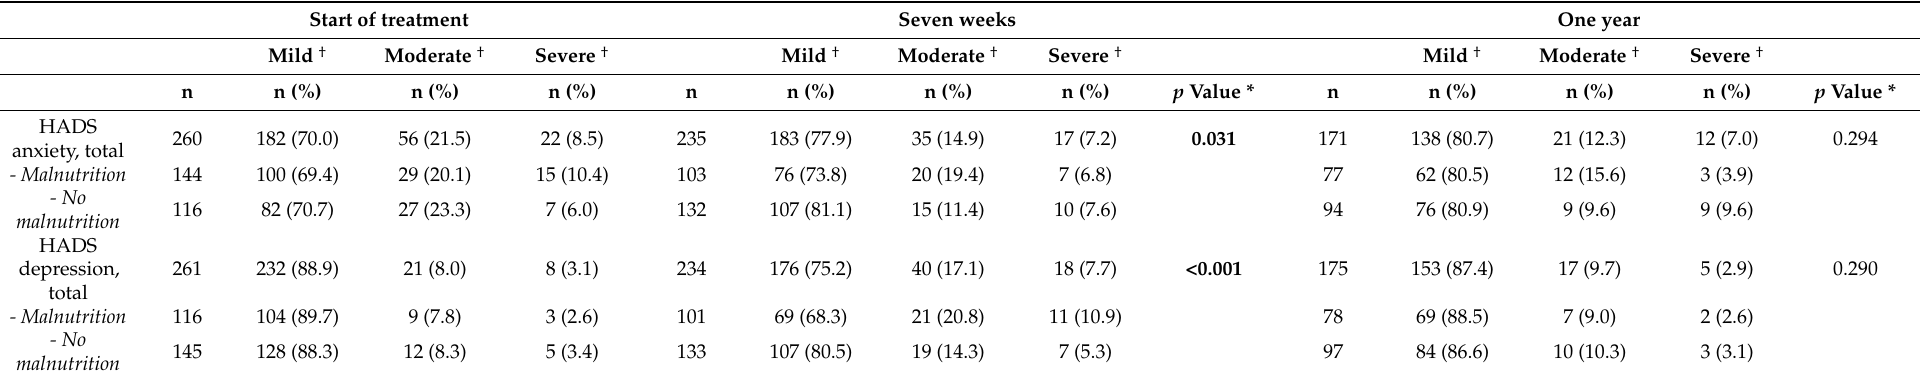
Table 4. The distribution of patients to different cut-off scores for the Hospital Anxiety and Depression Scale (HADS) at the start of treatment and the two follow-ups. Data is shown in total as well as patients with malnutrition defined by the Global Leadership Initiative on Malnutrition (GLIM) and patients without